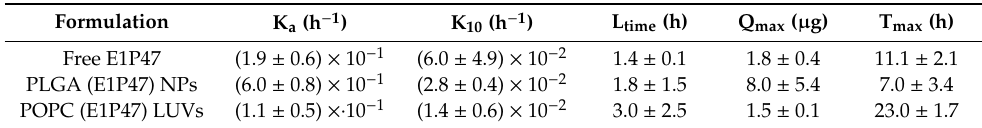
Table 2. Biopharmaceutical parameters of E1P47, PLGA (E1P47) NPs and POPC (E1P47) LUVs release. Values express the mean and standard deviation of two independent assays.